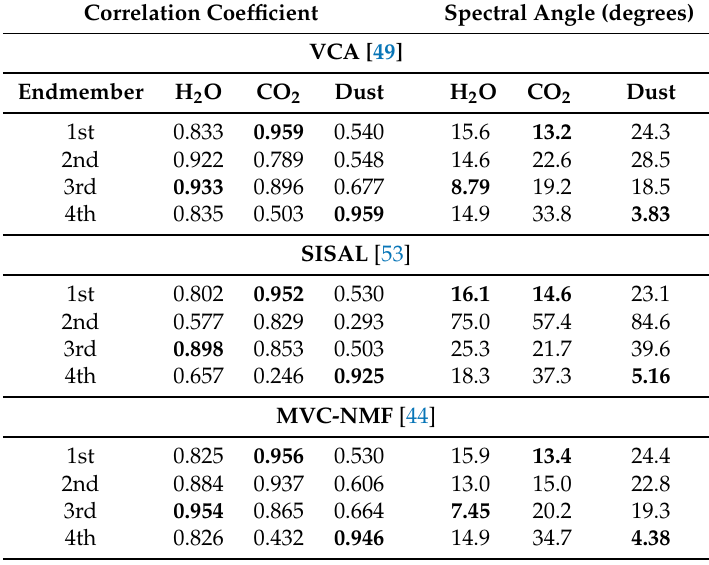
Table 10. Correlation coefficients and spectral angles between the reference spectra (in Figure 1) and the spectra of the endmembers extracted, respectively, by the use of VCA, SISAL and MVC-NMF with the ORB0041 image. A bold face stresses, in each case, the best